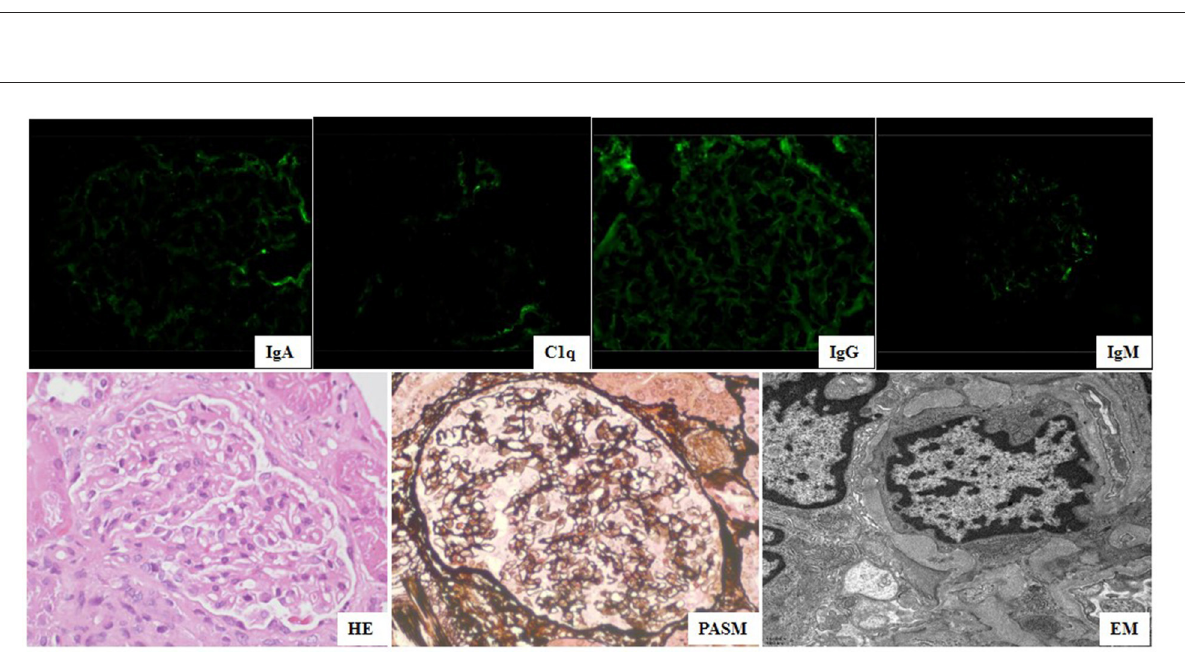
FIGURE2 Kidney biopsy of findings showed negative IgA, IgM, Clq, and faint IgG under immunofluorescence ( × 400) microscopy, normal glomerular change (HE&PASM: periodic acid-silver metheramine) under light microscopy ( × 400), diffuse podocyte foot process effacement (FPE) in absence of sub-epithelial or sub-endothelial deposition under electron microscopy ( ×